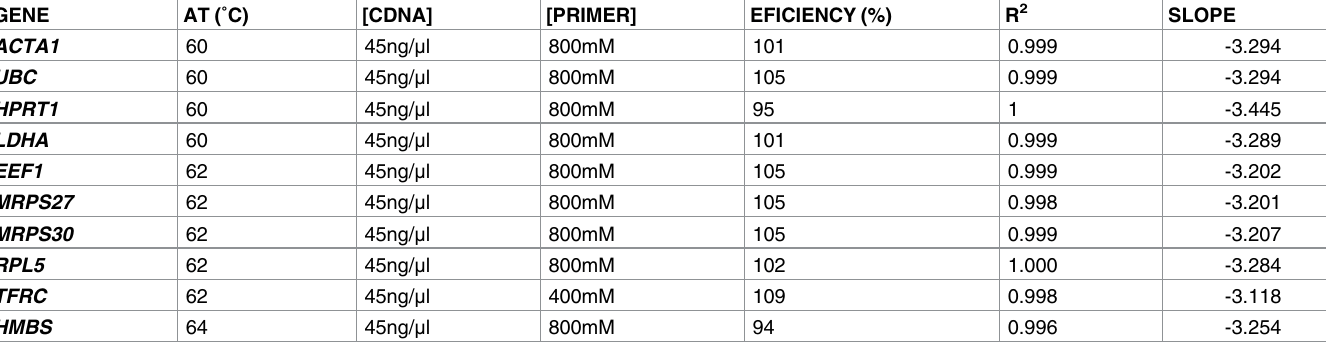
Table 3. Parameters of referencegenes primers specific for chickens obtained from efficiency curve analysis of RT-qPCR. GENE AT